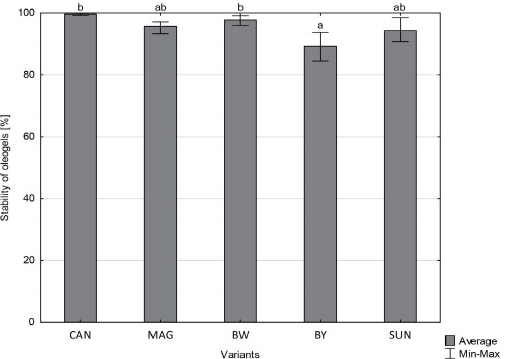
Figure 1. Share of unchanged oleogel structure after centrifugation, depending on the type of structure-forming substance: a,b—the same letters above bars indicate that there is no statistical difference ( α = 0.05).